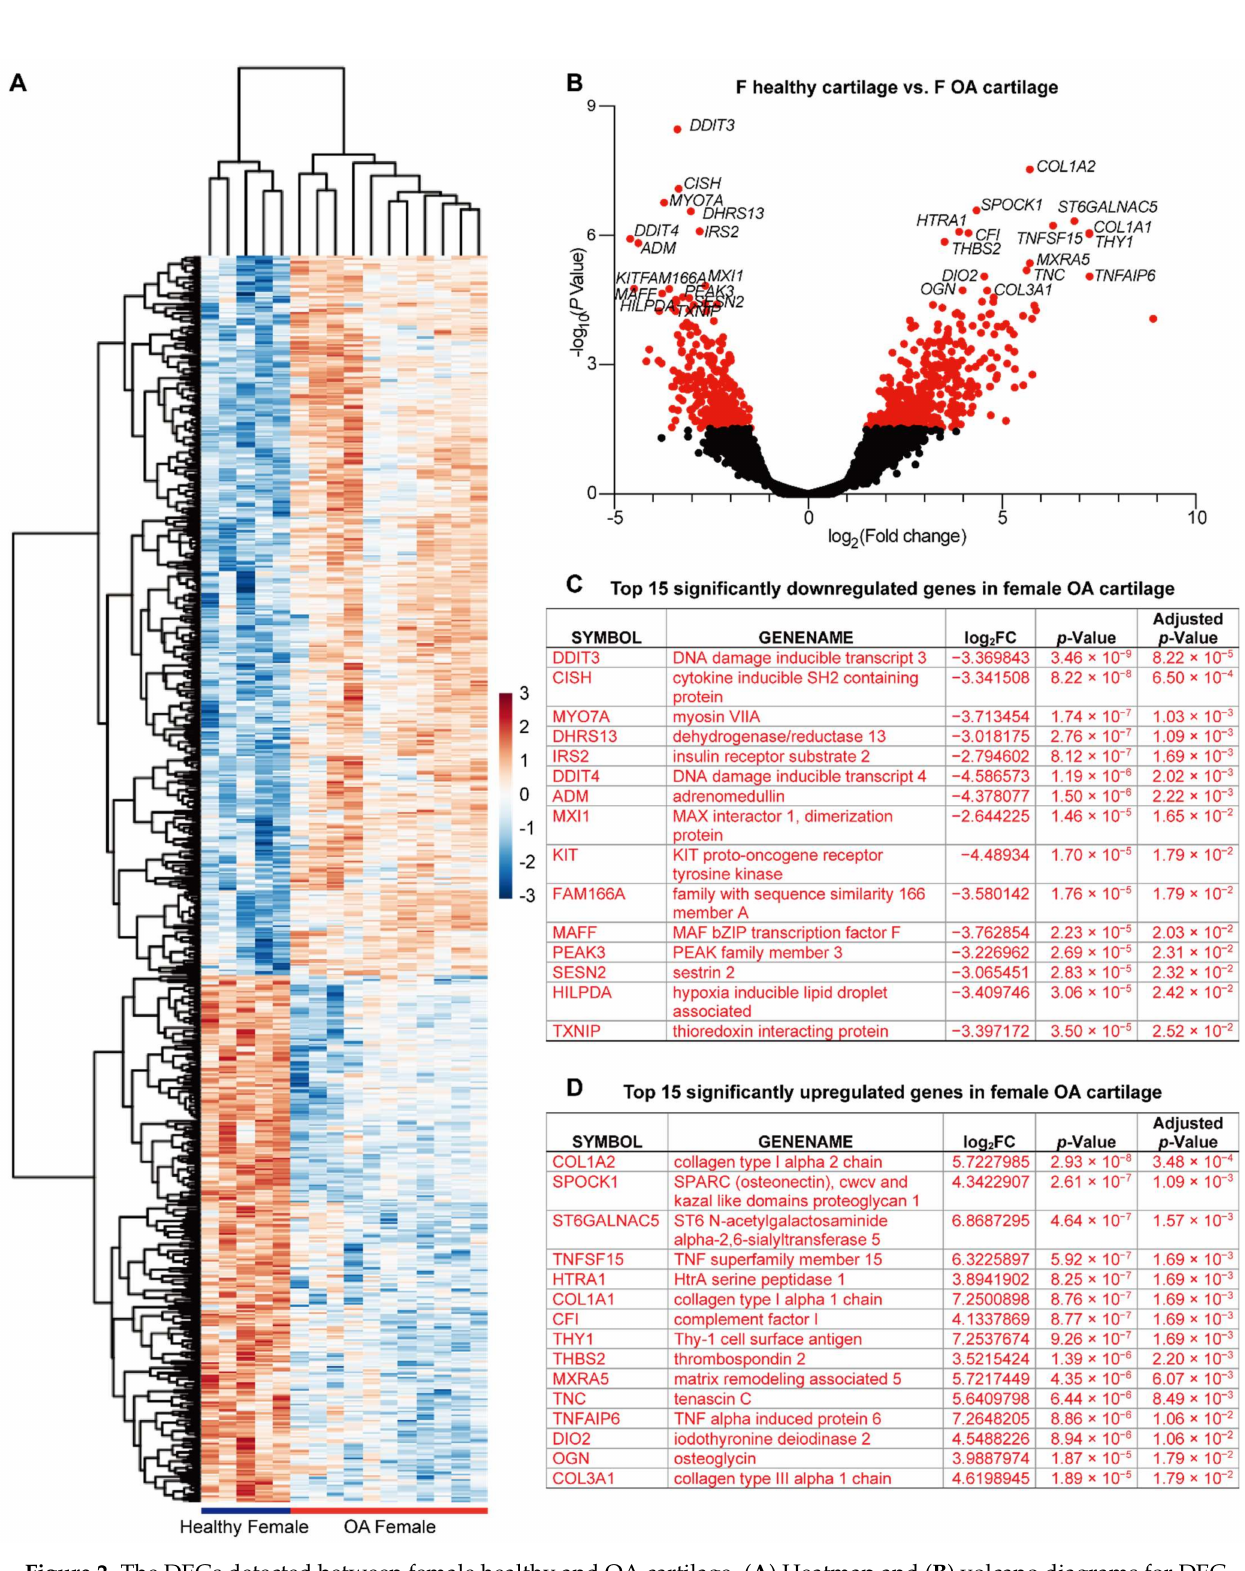
Figure 2. The DEGs detected between female healthy and OA cartilage. ( A ) Heatmap and ( B ) volcano diagrams for DEG visualization. DEGs with a p -value less than 0.05 are highlighted in red. ( C ) Top 15 genes significantly downregulated in female cartilage in response to OA. ( D ) Top 15 genes significantly upregulated in female cartilage in response to OA. DEGs with an adjusted p -value less than 0.05 are highlighted in